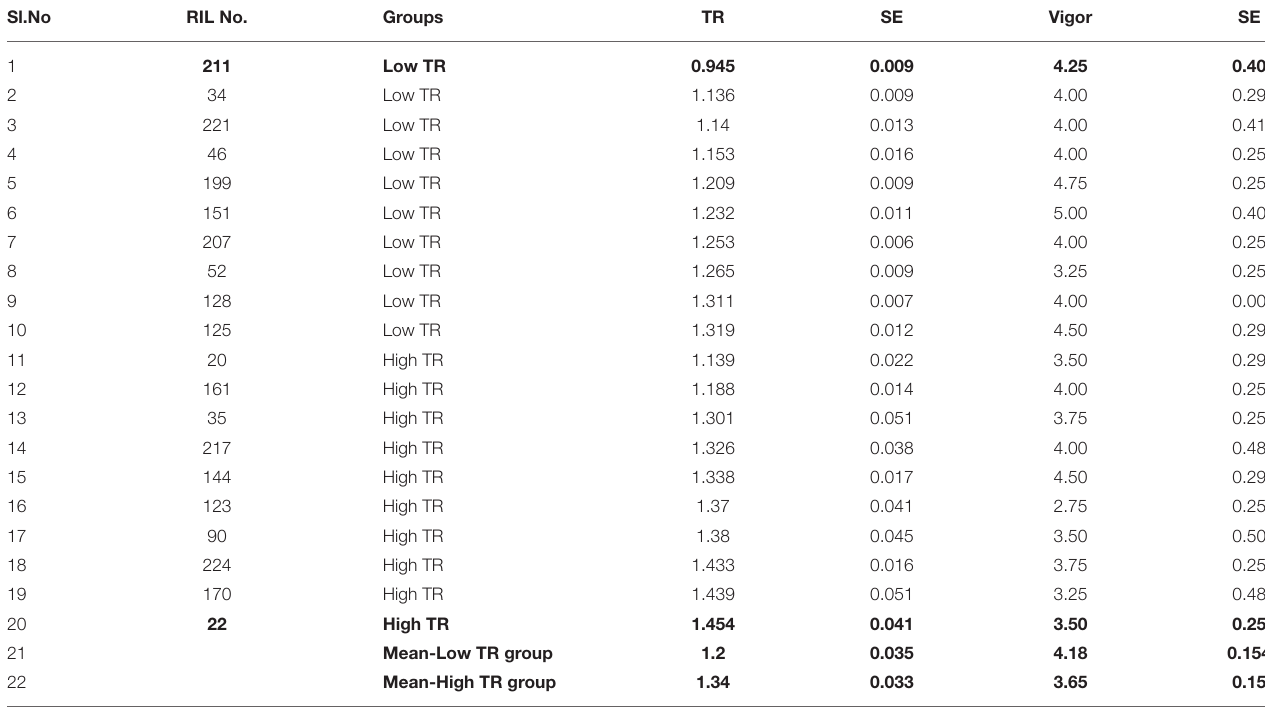
TABLE 1 | Details of mean transpiration rate (TR; mg H 2 O cm − 2 min − 1 ) and plant vigor score in chickpea genotypes contrasting for plant vigor and VPD response.